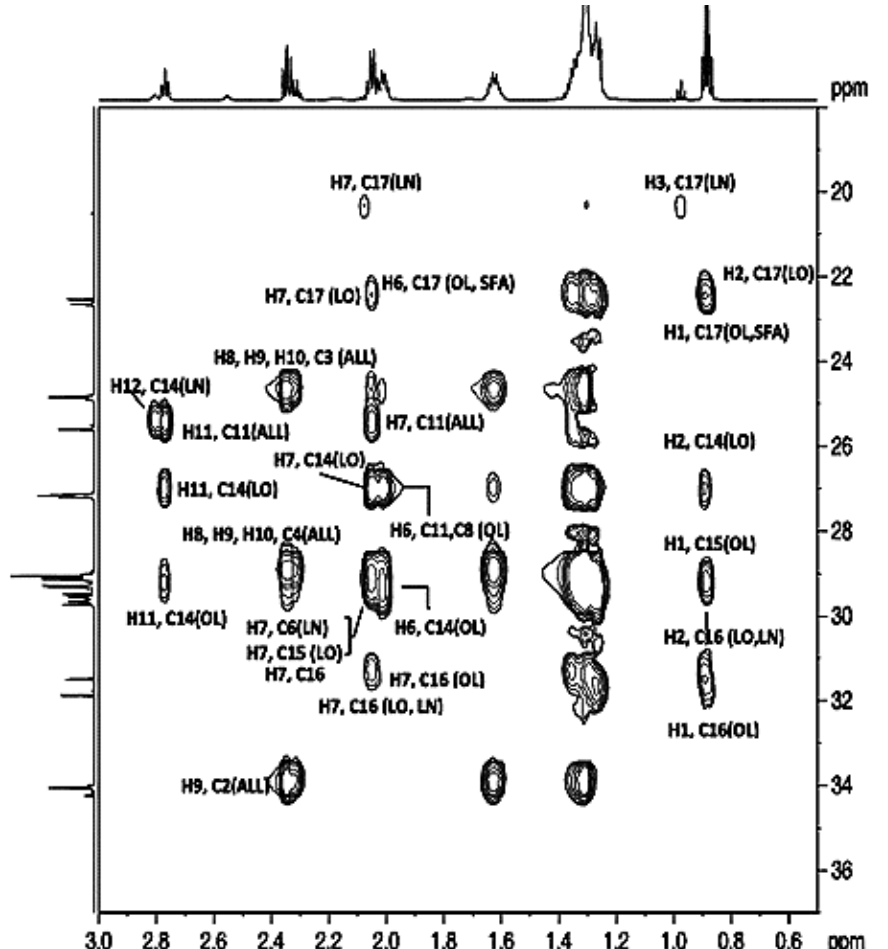
Figure 20. 600 MHz gHSQC-TOCSY spectrum of DAG oil in CDCl 3 solution, showing consecutive connectivities between carbons and protons along a common coupling pathway (for the notation system for 1 H resonances see the original article). Adopted, with permission, from [59]. Copyright 2011, Springer AOCS.